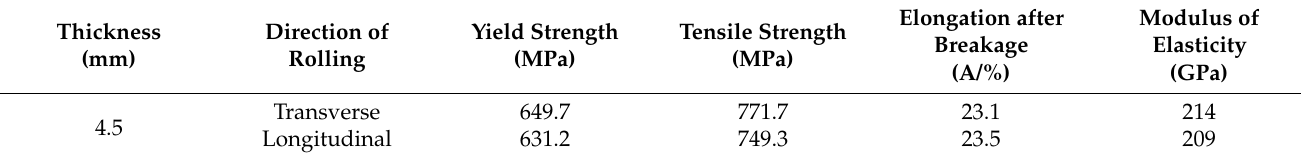
Figure 2. Geometric dimensions of 700L high-strength steel tensile specimen. Table 2. Tensile test results of 700L high-strength steel (thickness 4.5 mm).